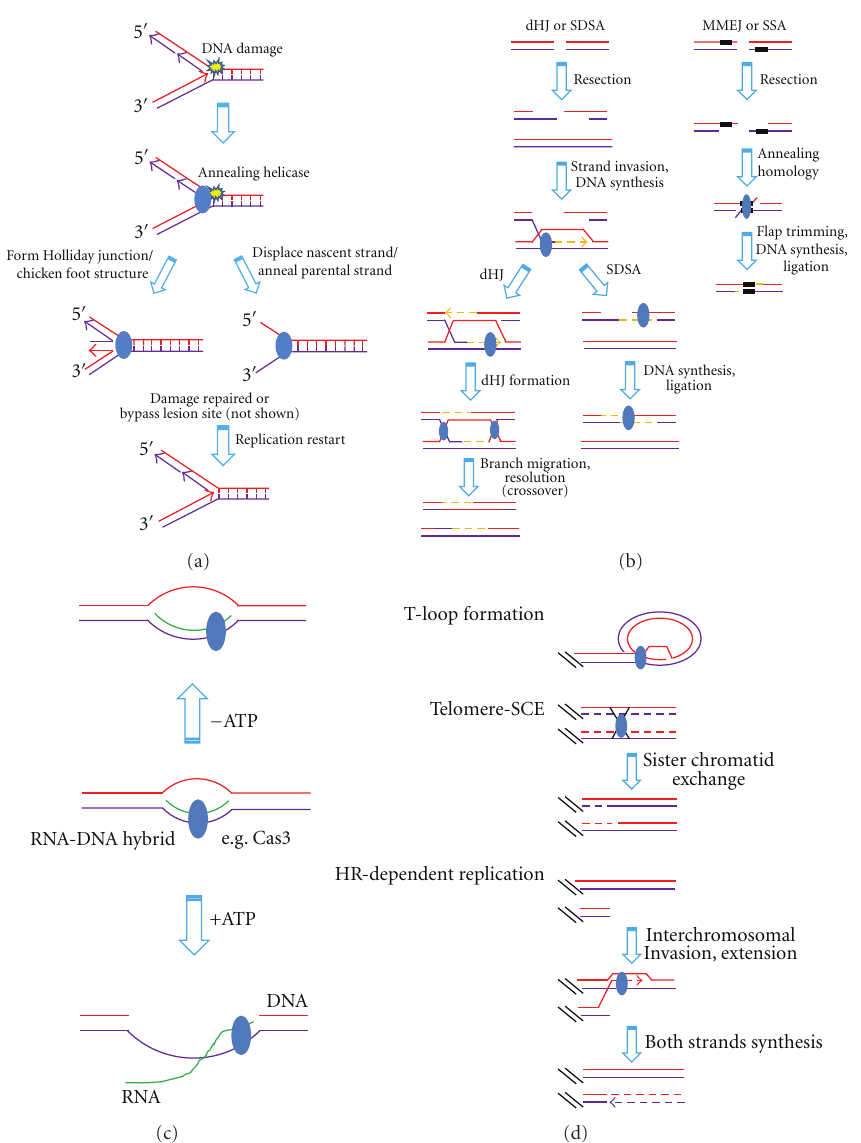
Figure 3: Purposed model of annealing helicase function in DNA replication, DNA repair, transcription, and telomere metabolism. (a) The annealing helicases function at stalled replication forks by catalyzing fork regression through Holliday junction migration (left) or displacing nascent strands and annealing parental strands (right). The replication fork proceeds until the DNA damage is repaired or bypassed. (b) Annealing helicases function in double-stranded DNA break repair. Annealing helicases might participate in homologous recombination repair through double Holliday junction (dHJ) or synthesis-dependent strand annealing (SDSA) pathways (left) or microhomology- mediated end joining (MMEJ) or single strand annealing (SSA) pathways (right). Noncrossover (uncommon) of dHJ is not shown. (c) Annealing helicases stabilize the DNA-RNA hybrid in transcription. Cas3 promotes RNA annealing to dsDNA without ATP and unwinding RNA from dsDNA with ATP. Model is adapted by analogy from one proposed for E. coli Cas3 helicase [89]. (d) Involvement of annealing helicases in telomere maintenance. Annealing helicases may catalyze the formation of T-loop structure or sister chromatid exchange and homologous recombination-dependent DNA replication in ALT cells. See text for